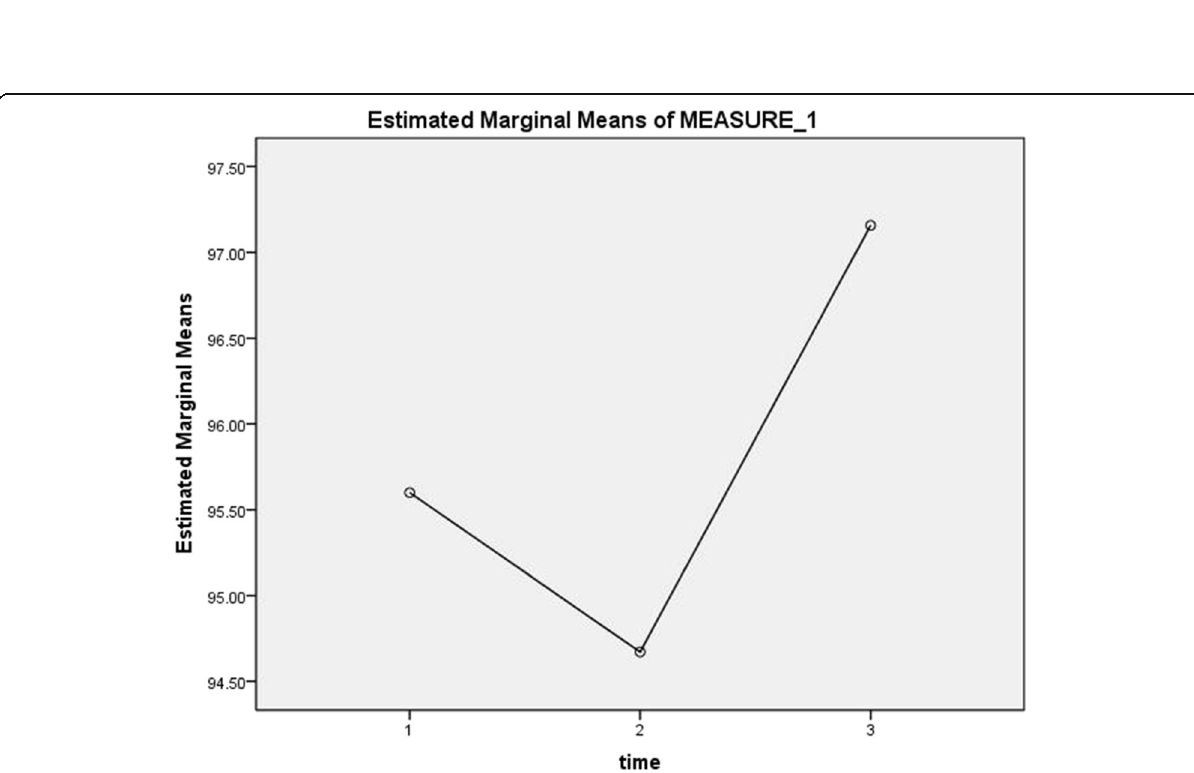
Fig. 2 Changes observed in oxygen saturation over time. Oxygen saturation was low at baseline and a further decrease was observed with nasal packing and significant improvement was detected after removal of nasal